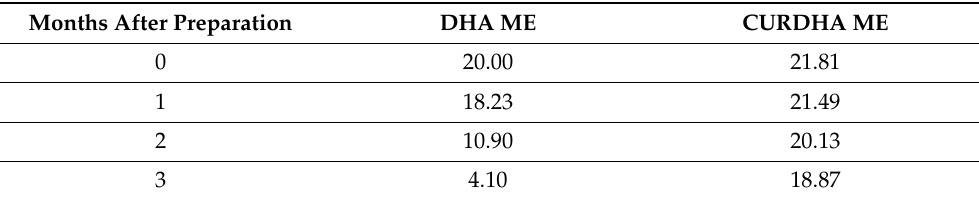
Table 1. DHA levels (mg/mL) in DHA and CUR-DHA loaded microemulsions during storage at 4 ◦ C.